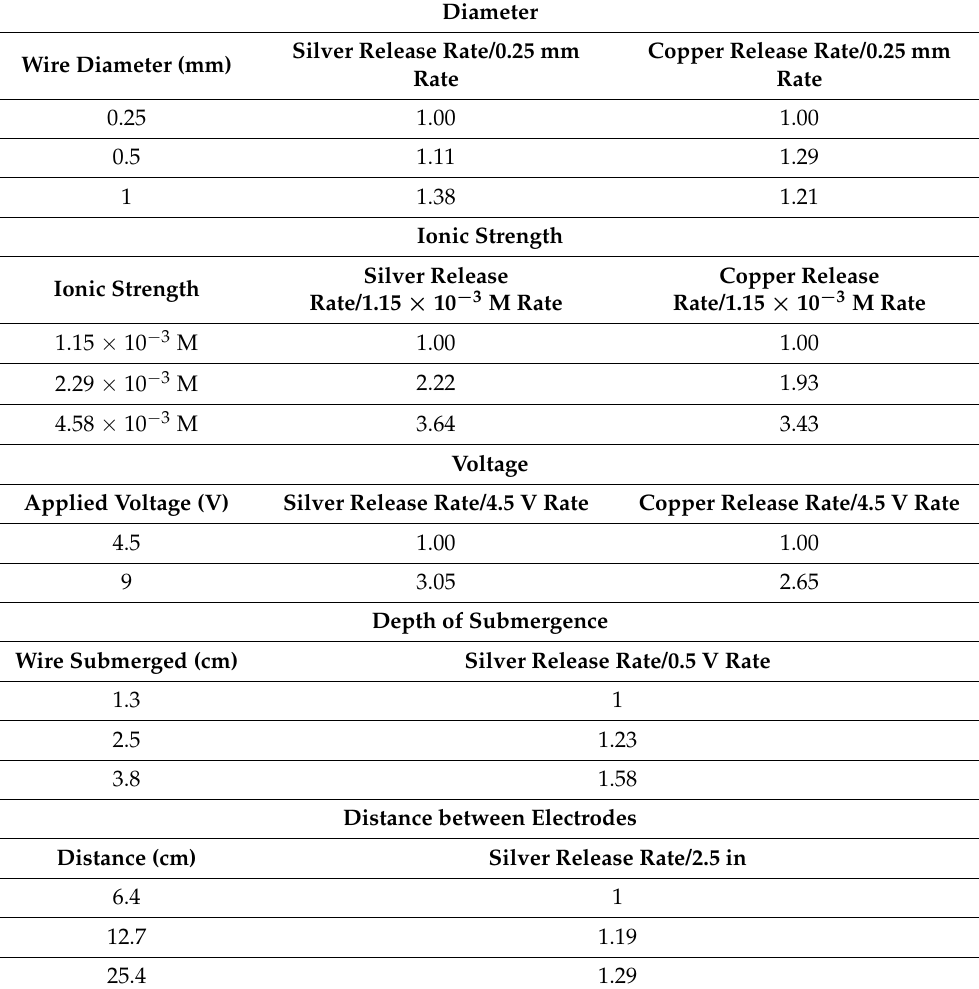
Table 1. Factors of increase in metal ion release with respect to diameter, ionic strength, wire submergence, distance between electrodes, or voltage